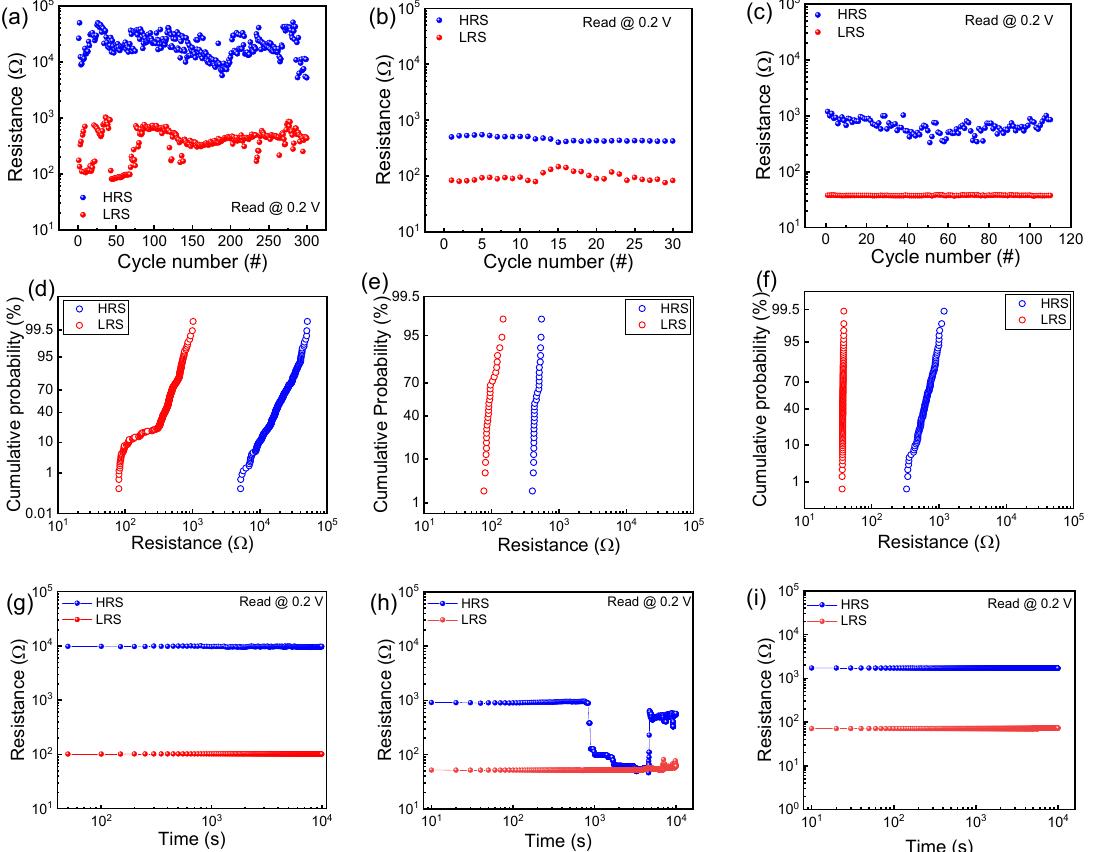
Figure 3. Reliability and variability characteristics of the TaO x / HfO 2 memristor: Endurance test for ( a ) filamentary; ( b ) interface-type; and ( c ) pseudo-interface-type switching. Cumulative probability for ( d ) filamentary; ( e ) interface-type; and ( f ) pseudo-interface-type switching. Retention test for ( g ) filamentary; ( h ) interface-type; and ( i ) pseudo-interface-type switching.